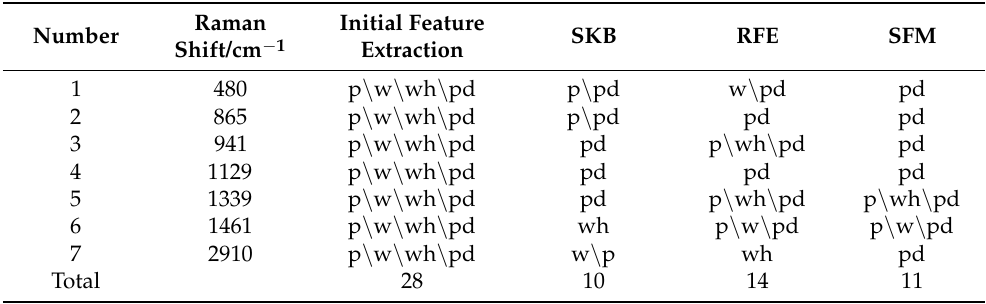
Table 3. Results of three methods for dimensionality reduction (p: prominences; w: width; wh: width_height; pd: